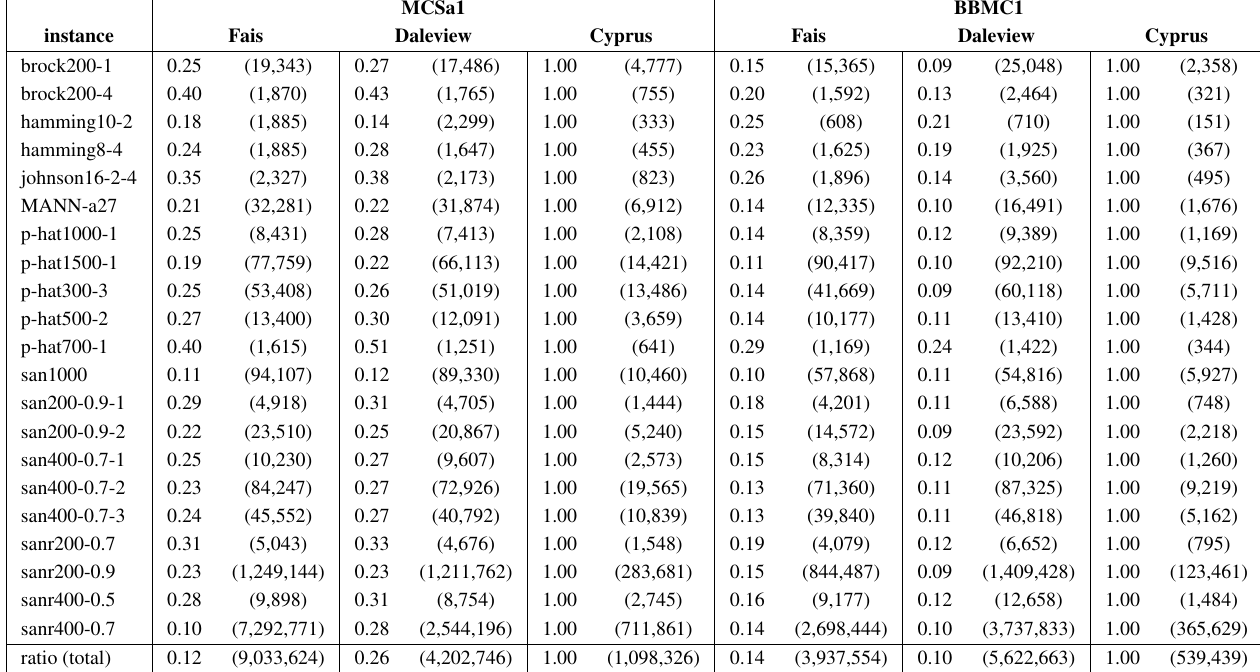
Table 8. Calibration experiments using 3 machines, 2 algorithms and a subset of